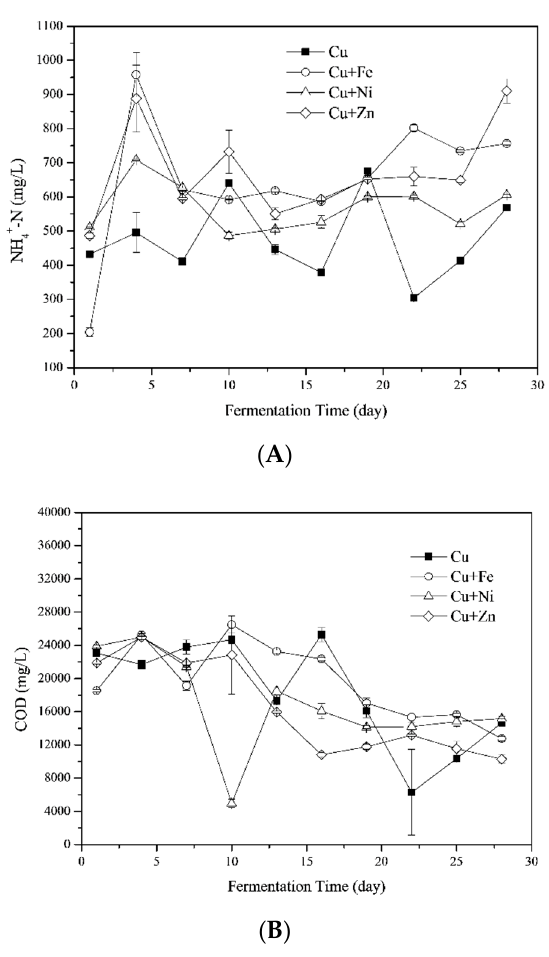
Figure 3. Ammonia nitrogen (NH 4+ -N) ( A ) and chemical oxygen demands (CODs) ( B ) during the fermentation process with Fe, Ni and Zn addition combined with Cu.